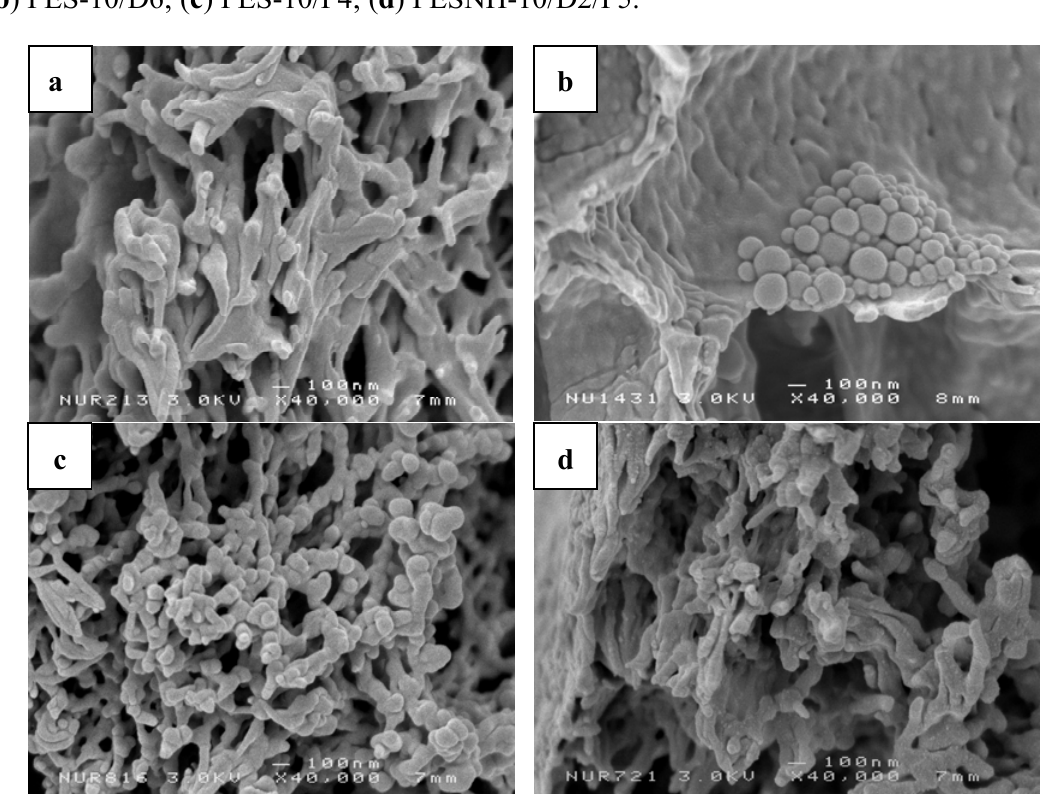
Figure 3. SEM image of membrane porosity with 40,000× magnification: ( a ) PES-10; ( b ) PES-10/D6; ( c ) PES-10/P4; ( d )